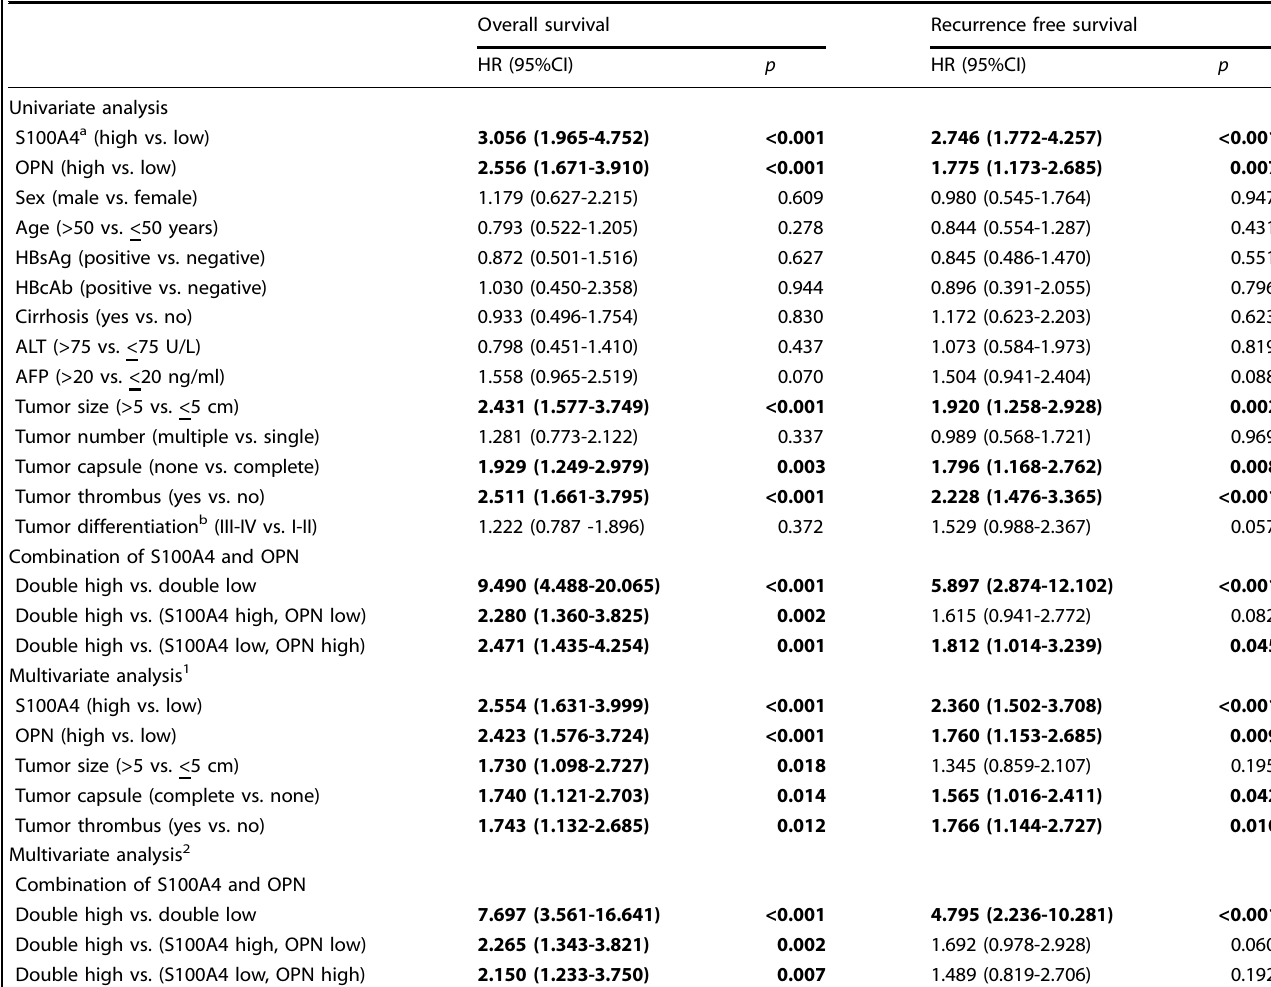
Table 2. Univariate and multivariate analysis of factors associated with survival and recurrence Overall